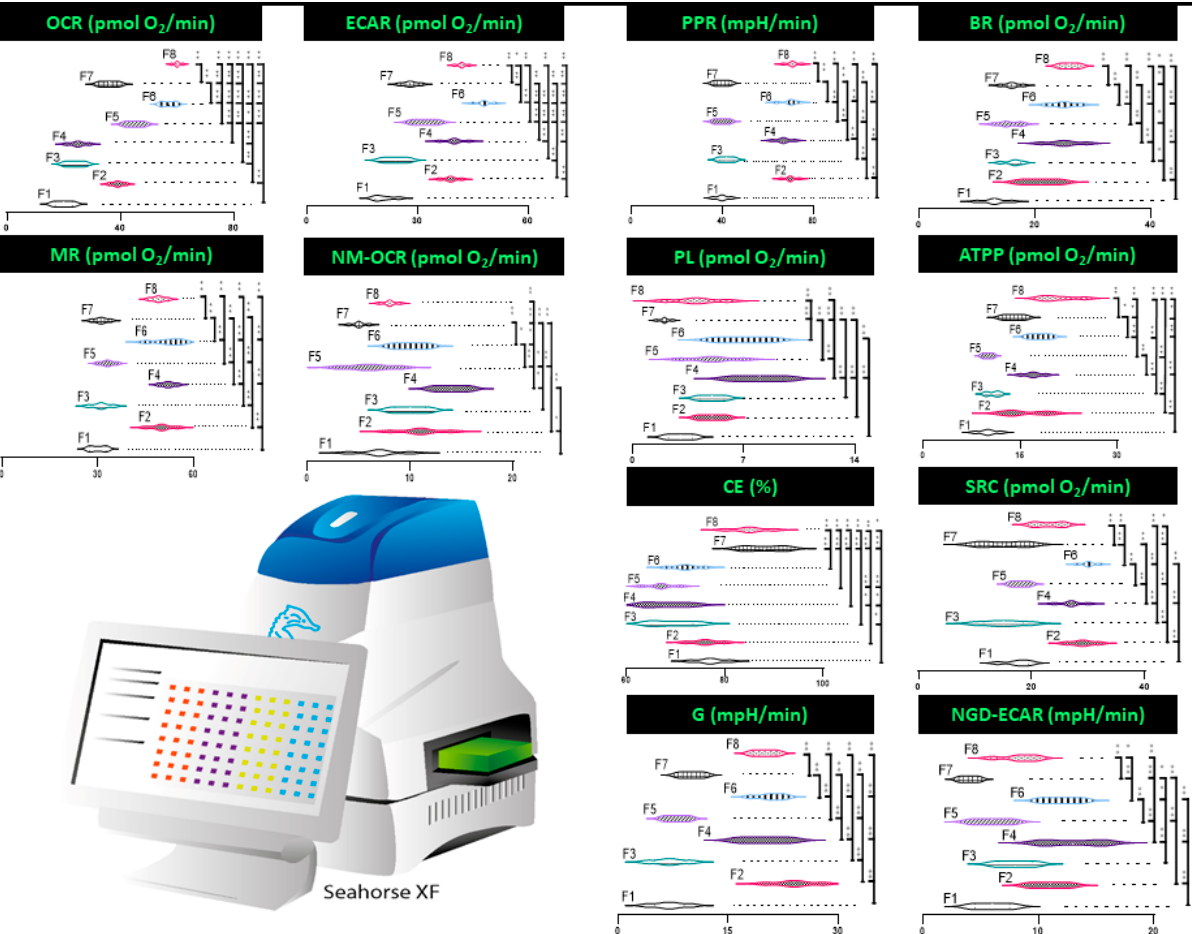
Figure 4. Cellular respiration parameters of encapsulated cells as measured by Seahorse XF platform. Measurements are oxygen consumption rate (OCR), extracellular acidification rate (ECAR), proton production rate (PPR), basal rate (BR), m rate (MR), non ‐ mitochondrial oxygen consumption rate (NM ‐ OCR), proton leak (PL), adenosine triphosphate production (ATPP), coupling efficiency (CE), spare respiratory capacity (SRC), glycoloysis (G), and non ‐ glucose derived extracellular acidficication rate (NGD ‐ ECAR). Data are mean ± SEM, n = 3. * p < 0.05, ** p < 0.01.